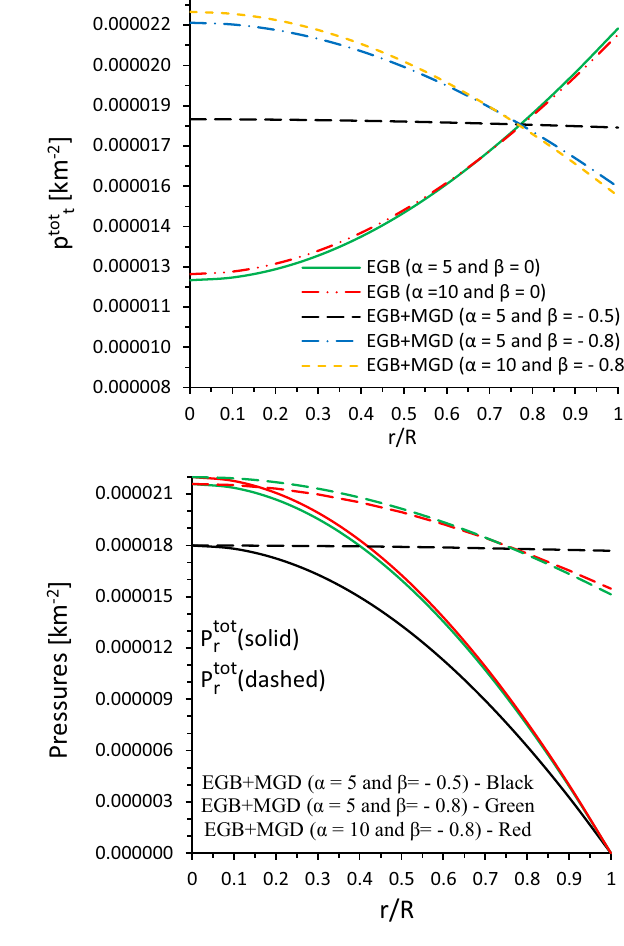
Fig. 2 Top panels : the left panel shows the total radial pressure ( p tot r ) andtherightpanelshowsthetotaltangentialpressure( p tot t )withrespect to the radial coordinate r / R . Bottom panels : The left panel represents the total energy density ( ρ tot ) and the right panel shows the total radial